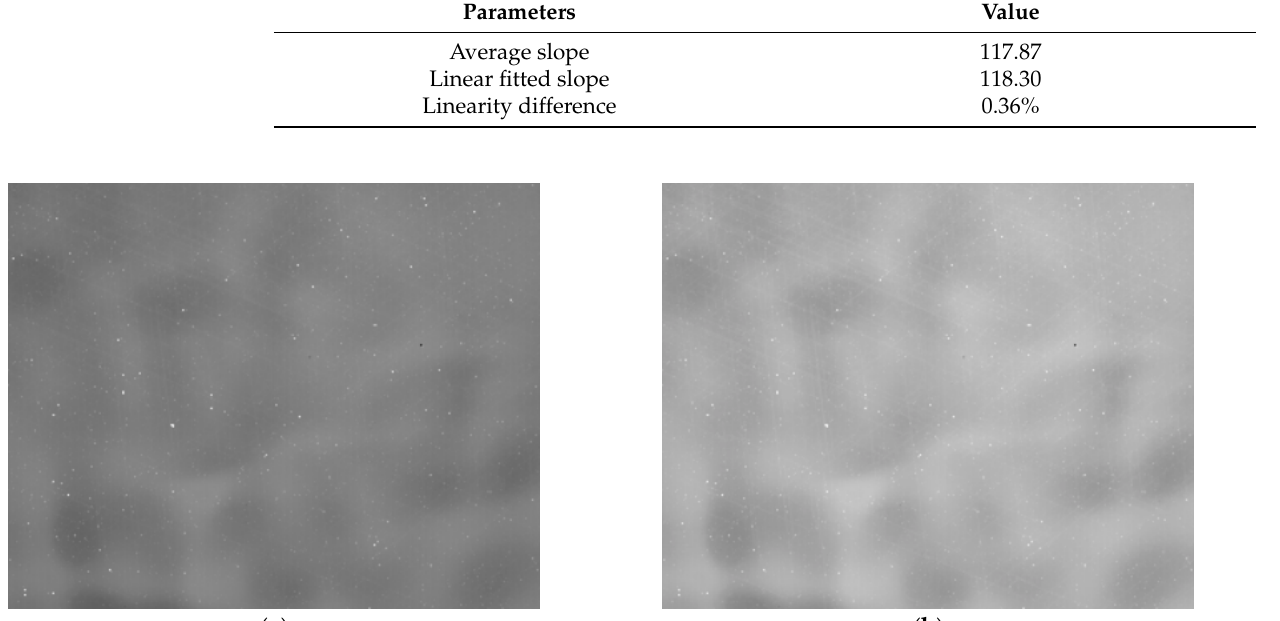
Figure 8. Blackbody reference raw images for low and high temperatures. ( a ) − 10 °C reference image (average gray value 7591DN); ( b ) 10 °C reference image (average gray value 10117DN). Table 2. Response linearity of IRFPA for the range − 20~10 ℃ .